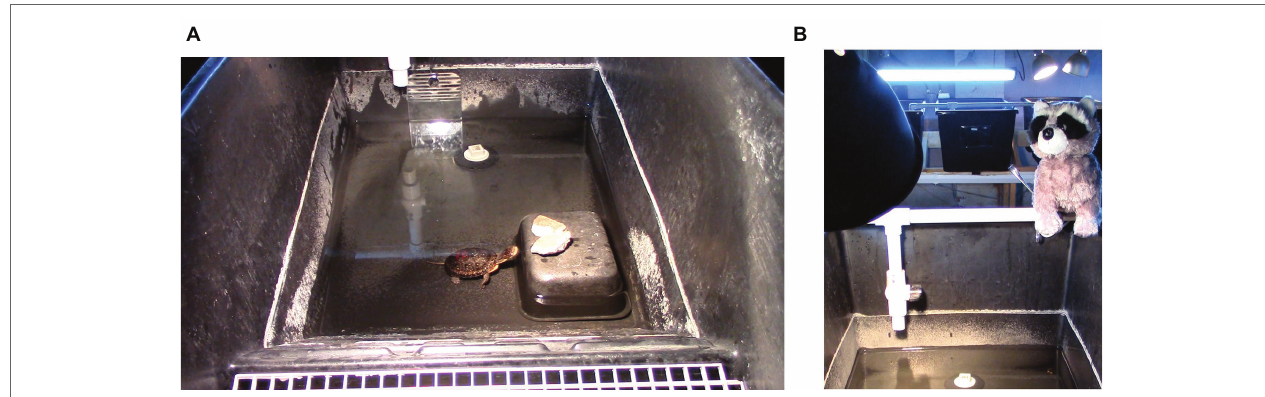
FIGURE 1 | (A,B) Enclosure used for housing turtles and as the arena for the four modified open field tests used to assess Blanding’s turtle personality. (A) The arena during the second test (mirror test). (B) The arena during the fourth test (predator test), with the mock-predator present and other turtle enclosures visible in the